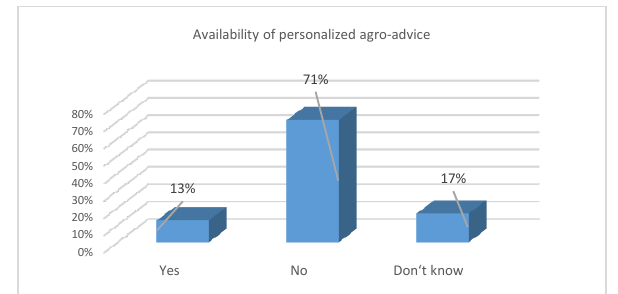
Figure 5: Availability of personalized agro-advice